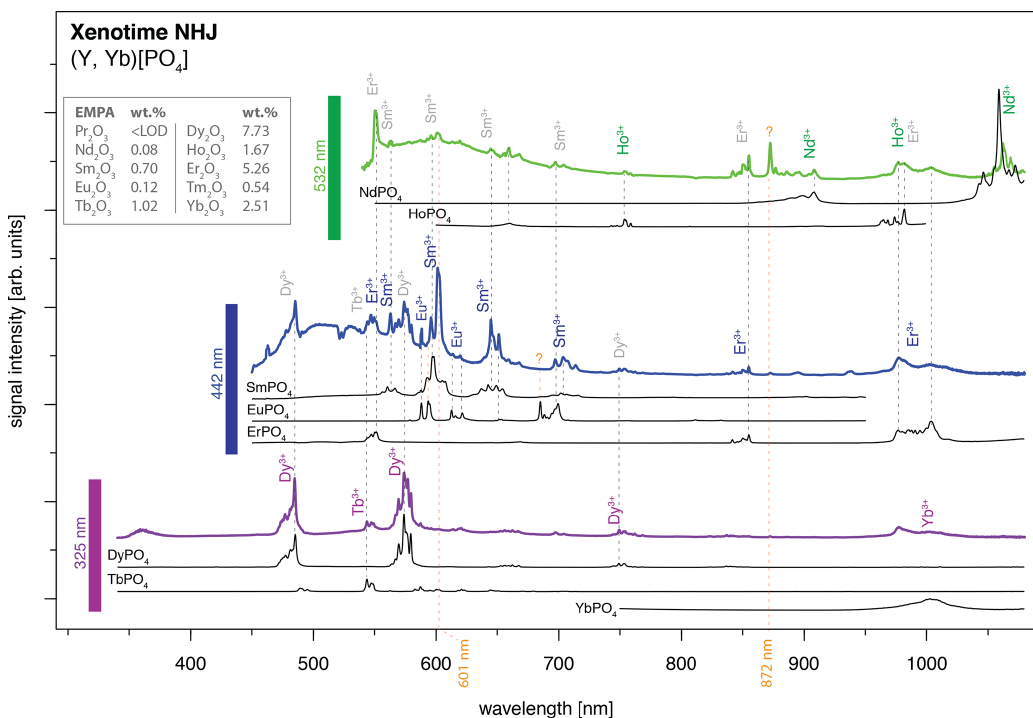
Figure 11. Application of the presented LiF spectral library for REE identification in a natural mineral: xenotime from Novo Horizonte, sample NHJ (see Turner, 2015, and Lorenz et al., 2019). The measured spectra from the three different laser excitation wavelengths are offset, and luminescence intensities of individual spectra are scaled for better visualisation of observed emission lines and potential reference emission peaks (arbitrary units: comparison of signal intensities between spectra is not